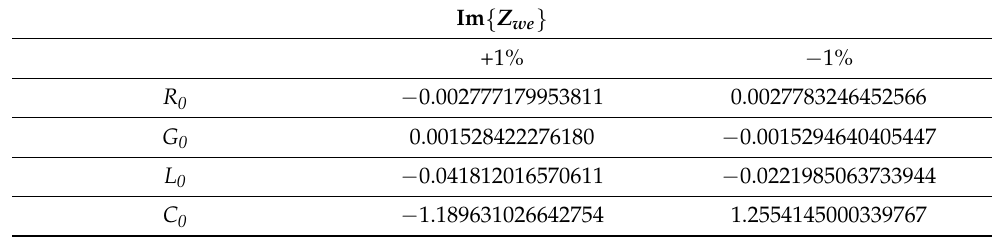
Table 5. Changes to the imaginary part of the input